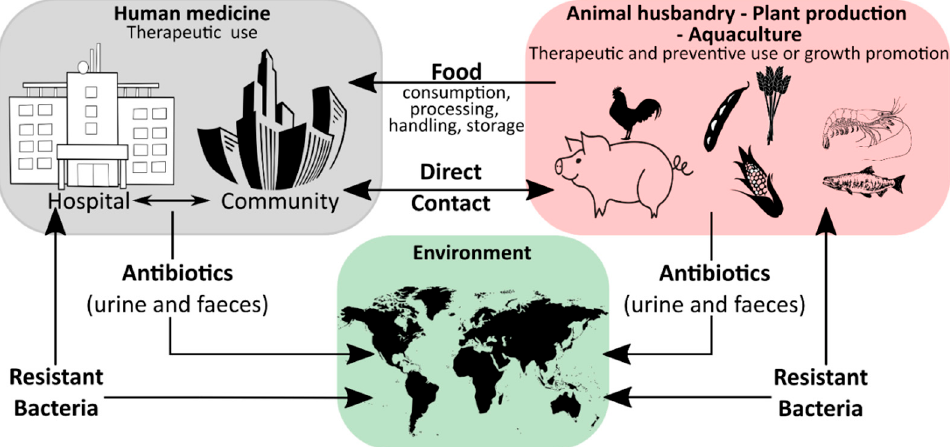
Figure 1. A schematic overview of the ecology of antibiotics, showing how these drugs are circulated between different environments, such as the medical environment, agricultural settings, the aquacultural environment, the pharmaceutical industry and the wider environment, adapted from [9].